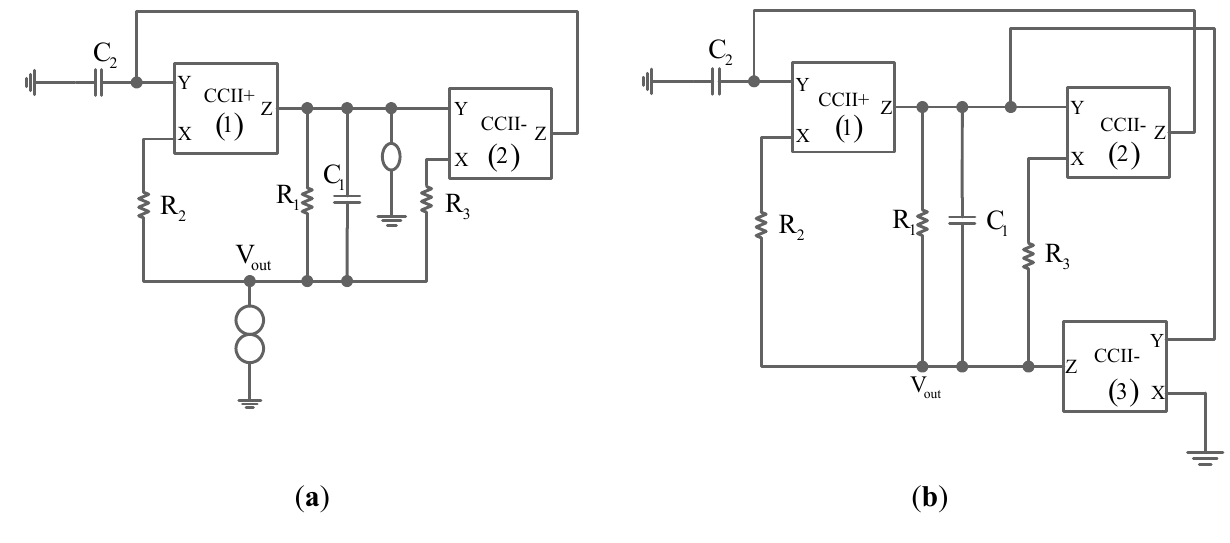
Figure 5. ( a ) The obtained oscillator; ( b ) realization of the obtained oscillator in ( a